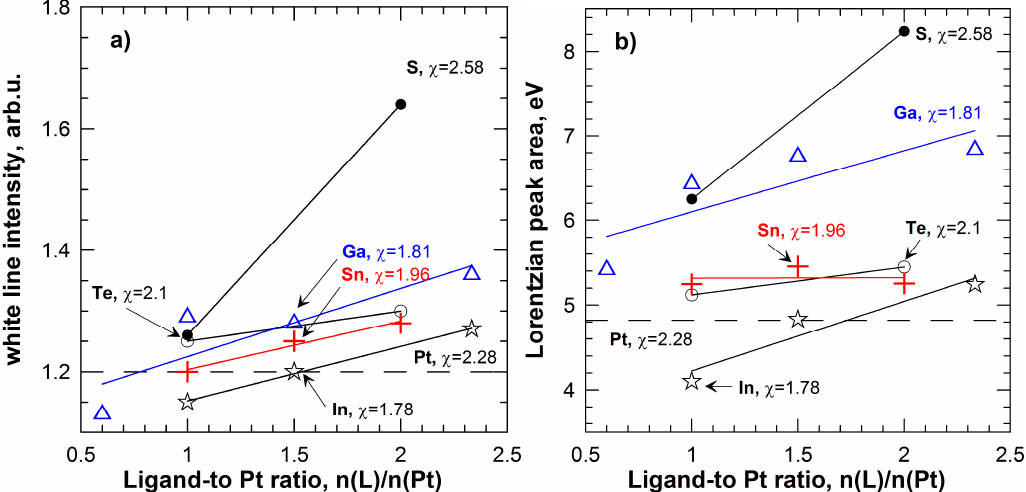
Figure 11. Normalized intensity of Pt L 3 -edge white line ( a ), and area of Lorentzian function which approximate the white line ( b ). The ligand-to Pt ratio is shown in X axis. Symbols correspond to calculated values. The ligand type and the electronegativity of the ligand χ is given for each group of compounds.